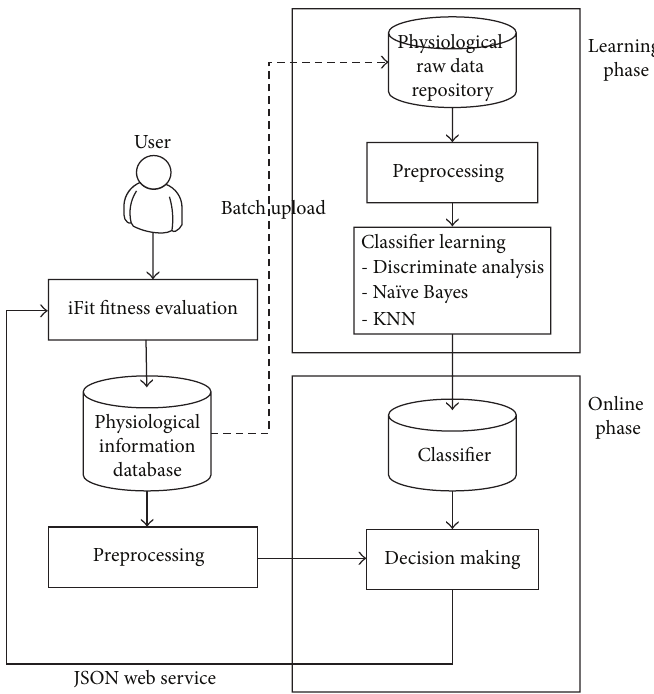
Figure 4: Process of classifier learning and decision